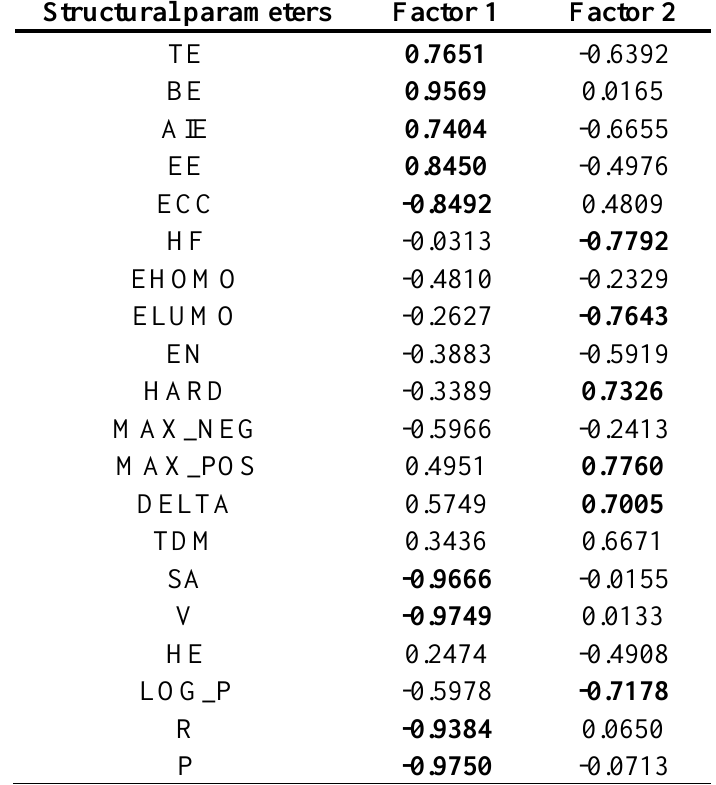
Table 4. Principal component analysis loadings by structural